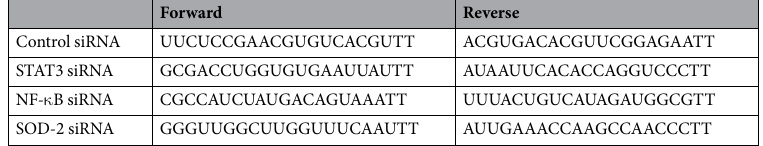
Table 2. Gene expression was normalized against the housekeeping gene β -actin. Relative gene expression was calculated by the comparative ΔΔ Ct method according to the manufacturer’s instructions.